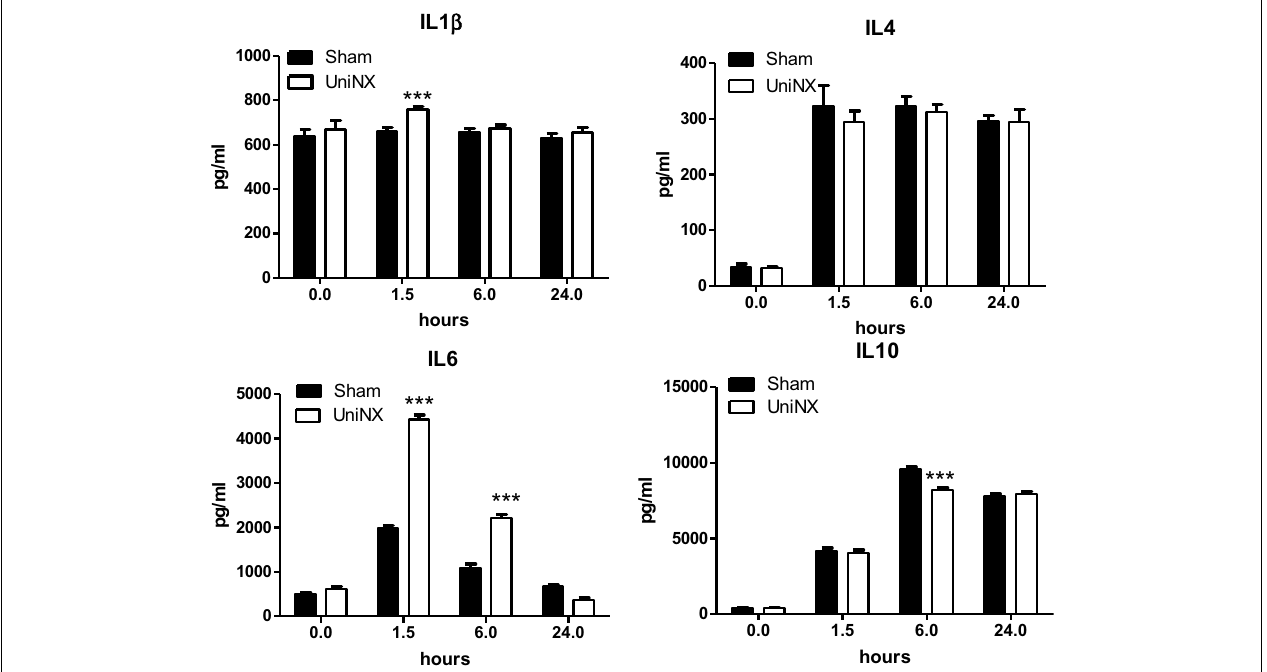
FIGURE 3 | Circulating levels of IL1 βββ , IL4, IL6, and IL10, in Sham-operated and UniNX rats at 0, 1.5, 6, and 24h after i.p. LPS injection . Values are means (cid:6) SE; n = 8/group. *** p < 0.001 corresponds to Sham vs. UniNX.